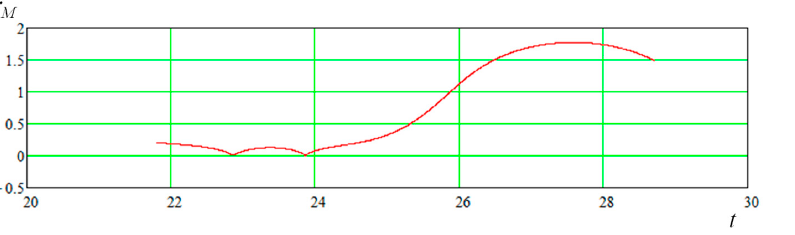
Figure 24. Relative selenocentric r M [undim.] distance between the position of the SC and the final circular orbit of a given radius. Figure 25. Relative selenocentric distance r M [undim.] of the SC to a circular orbit of a given radius (enlarged). Two points of intersection of the curve and the time axis are clearly visible, correspond- ing to the possible moments of entering a given circular orbit. For the presented dependence, we are primarily interested in the range of the argu- ment t —dimensionless time—for which the sign of the relative distance changes. Because On the boundaries of the such regions, there are points of intersection between the